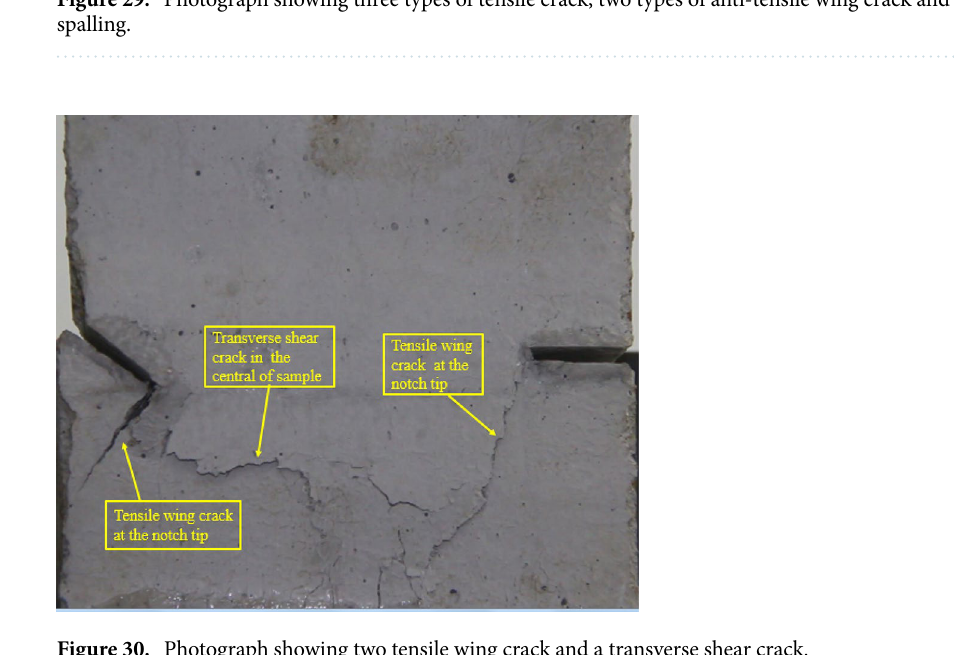
Figure 30. Photograph showing two tensile wing crack and a transverse shear crack.